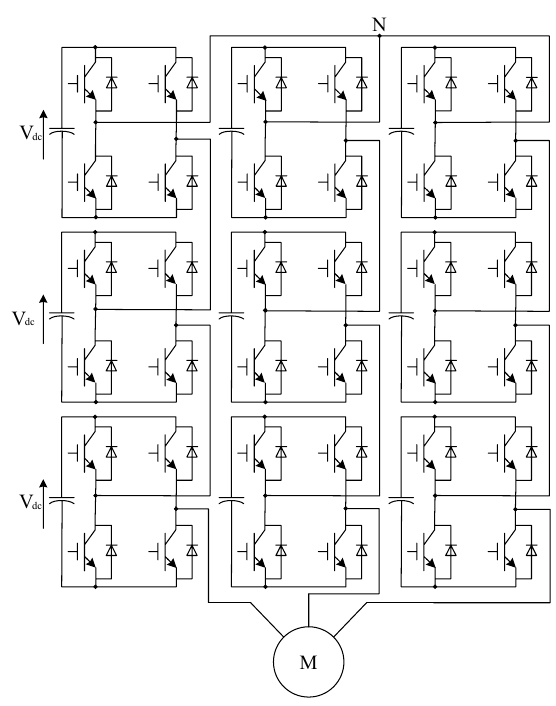
Figure 39 Multilevel cascaded H-bridge